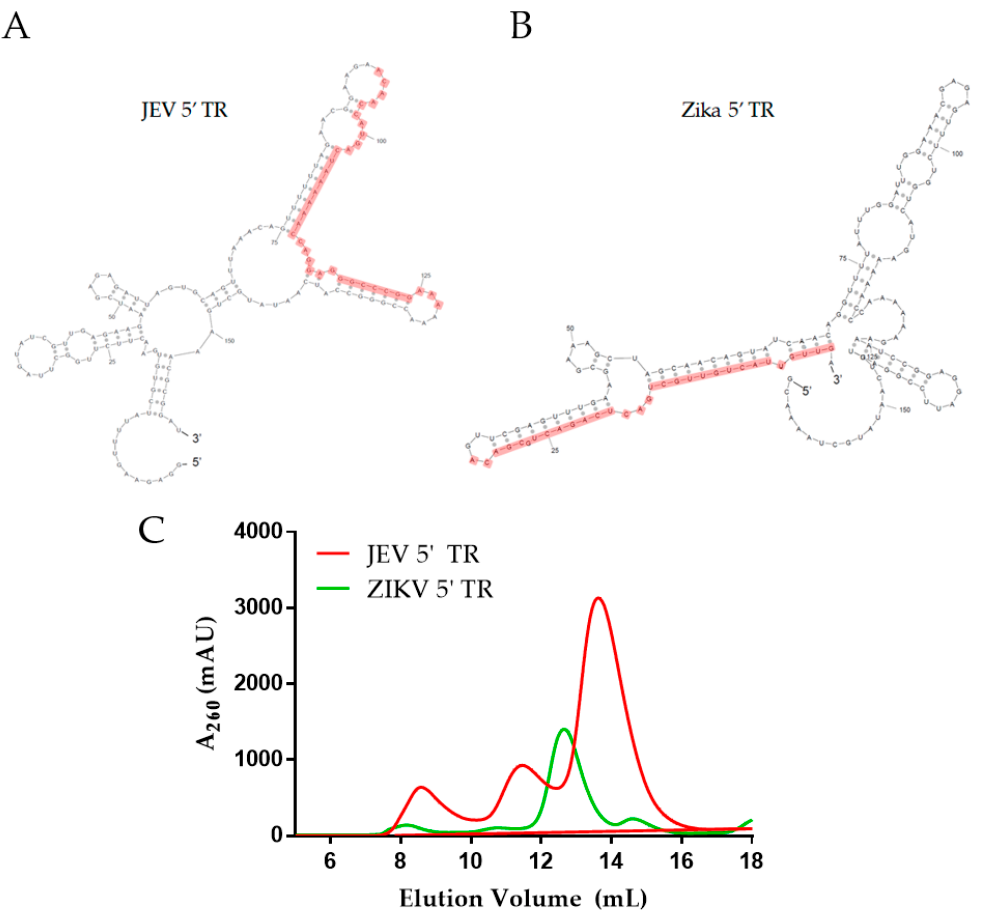
Figure 2. ( A and B ) Predicted secondary structure (sfold) for the 5 (cid:48) terminal regions (TRs) of Japanese encephalitis virus (JEV) 5 (cid:48) and Zika virus (ZIKV), respectively. The regions highlighted in red colour indicate the sequence complementary to the DNA oligo used in the helicase assays. ( C ) Size exclusion chromatography elution profiles of the 5 (cid:48) TRs of JEV (red) and ZIKV (green). Arrows indicate peaks that represent monodispersed fractions of RNA, which were used for downstream experiments. Y-axis represents absorbance at 260 nm while the x-axis represents elution volume.